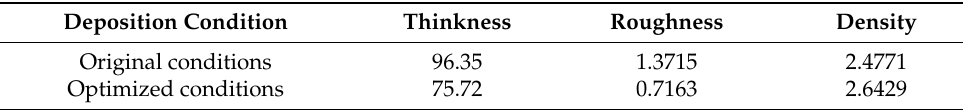
Figure 11. XRR measured and fitted patterns of SiO 2 films deposited under original and optimized conditions. conditions. Table 4. The fitted date of SiO 2 films for both conditions. Table 4. The fitted date of SiO 2 films for both